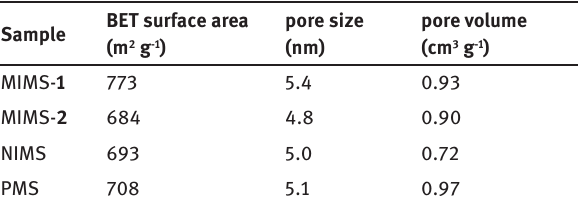
Table 2: Physical properties of prepared materials.